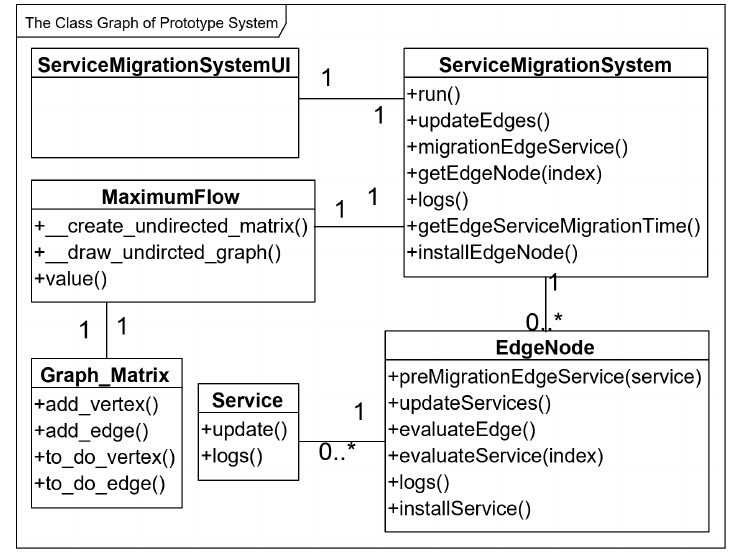
Figure 3. The class graph of prototype